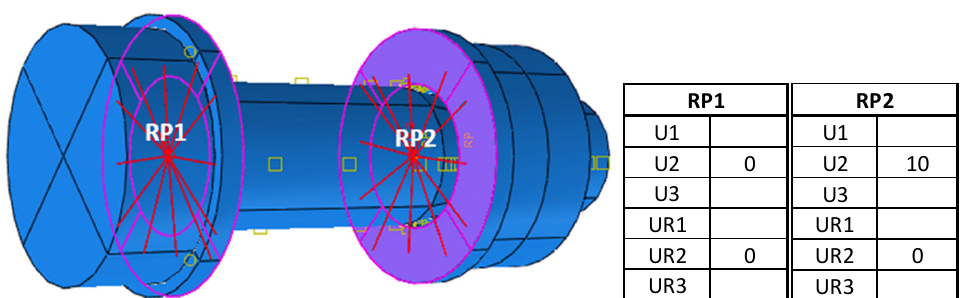
Figure 2. Position of the RPs used to apply boundary conditions.